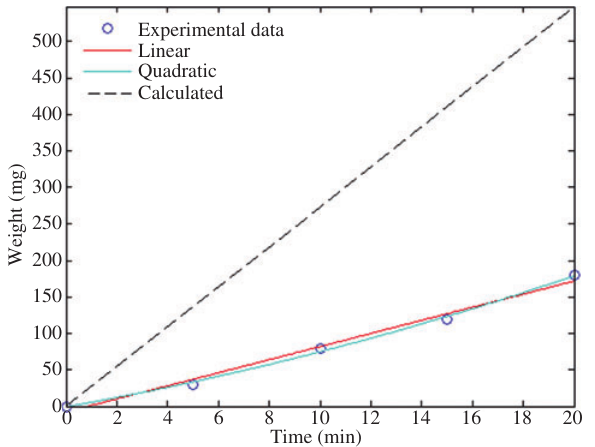
5 minute arc durations, respectively.